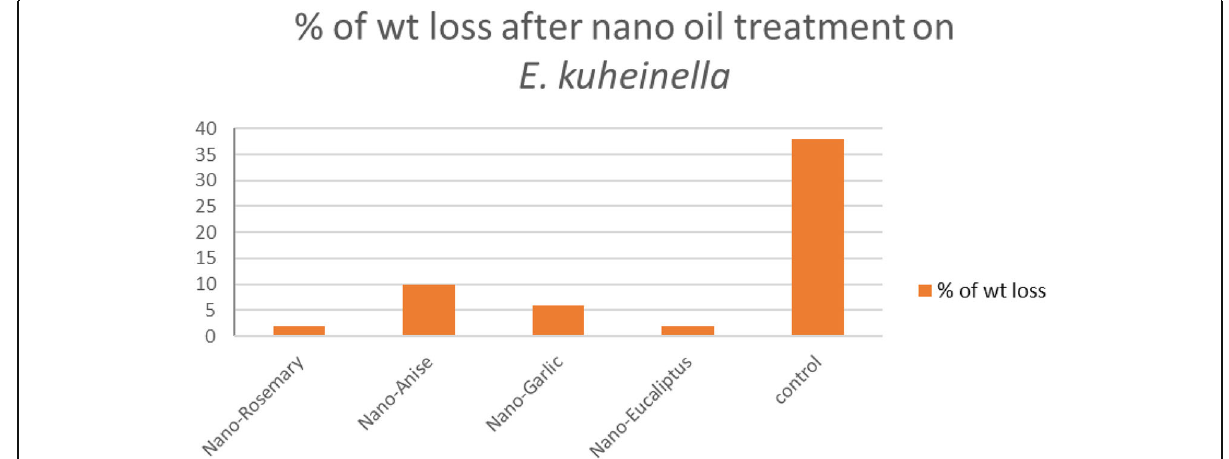
Fig. 1 Percentage of grain weight loss after nano oil treatment on E. kukeiella